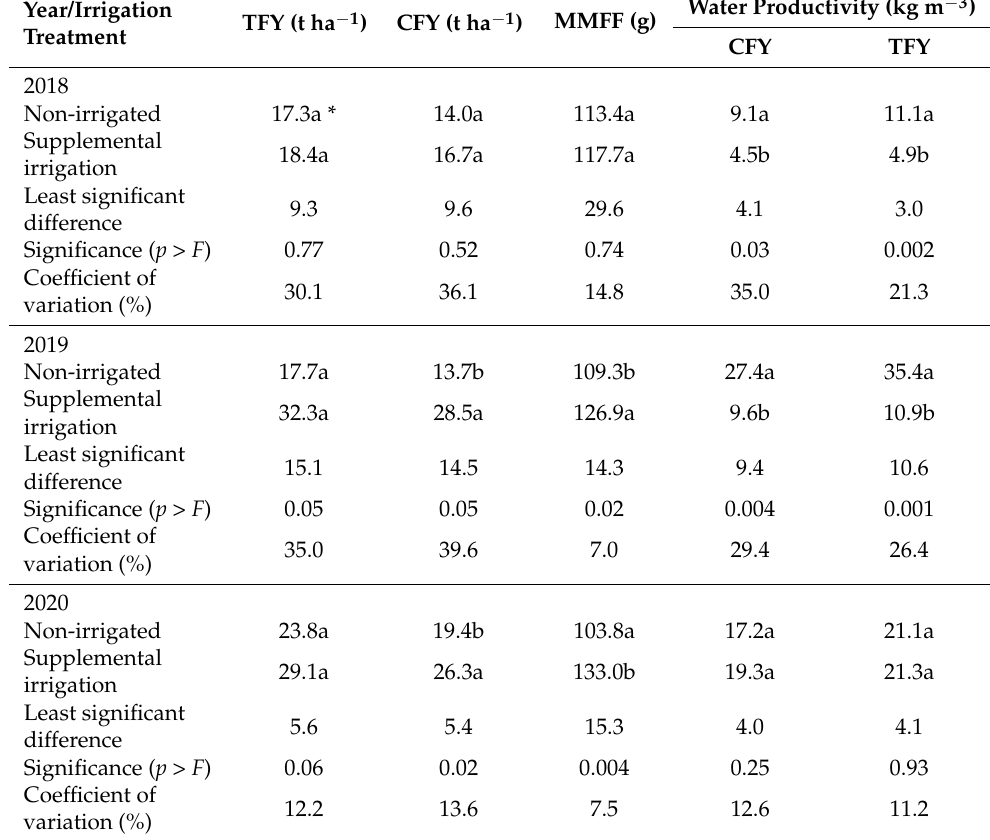
Table 2. Influence of supplemental irrigation on total fruit yield (TFY), commercial fruit yield (CFY, Grade 1 + Grade 2), and mean mass of fresh fruit (MMFF) and water productivity of ‘Roja Lisa’ cactus pear. Fruit were harvested from the commercial orchard ‘Las 100 Hect á reas’. La Victoria, Pinos, Zacatecas,